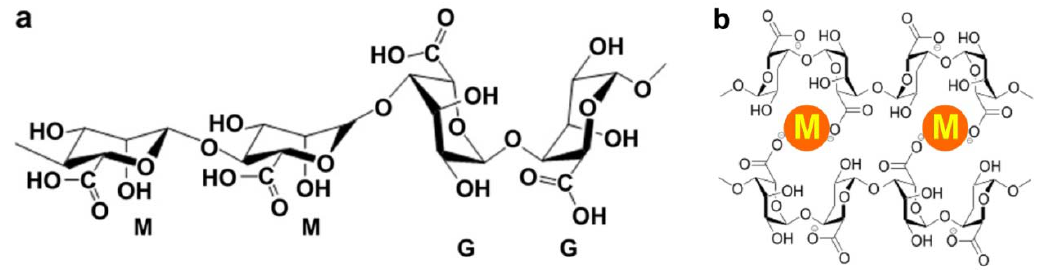
Figure 1. ( a ) Chemical structure of alginate; ( b ) Mechanism of ionic interaction between alginate and divalent